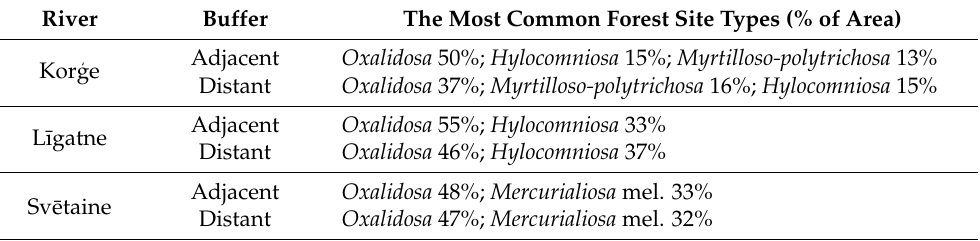
Table 1. The most common forest site types (%) in adjacent (0–50 m) and distant (51–200 m) riparian forest buffer strips for each river. The forest types are based on eastern Baltic phytocoenological classification (in Latin).